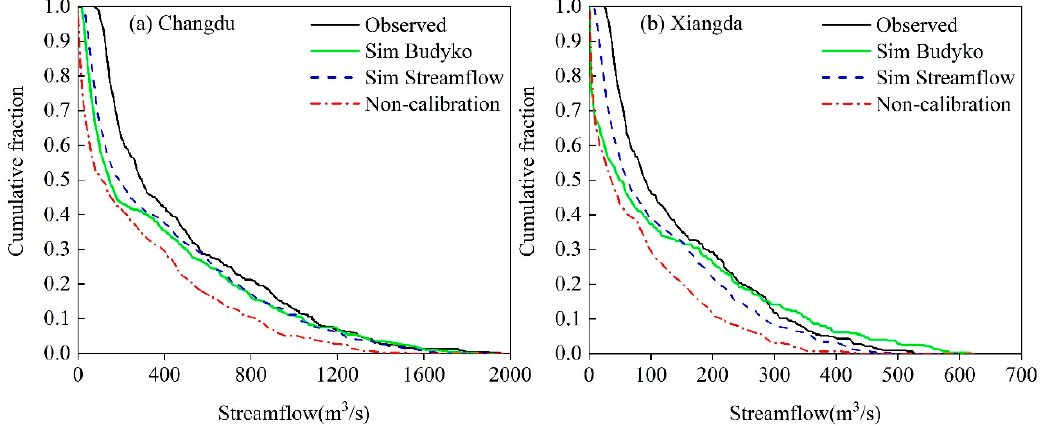
Figure 7. Cumulative distribution functions of monthly streamflow of the three calibration ap- proaches (Sim Budyko, Sim Streamflow, Non-calibration). ( a ) Changdu hydrological station; ( b ) Xiangda hydrological station.